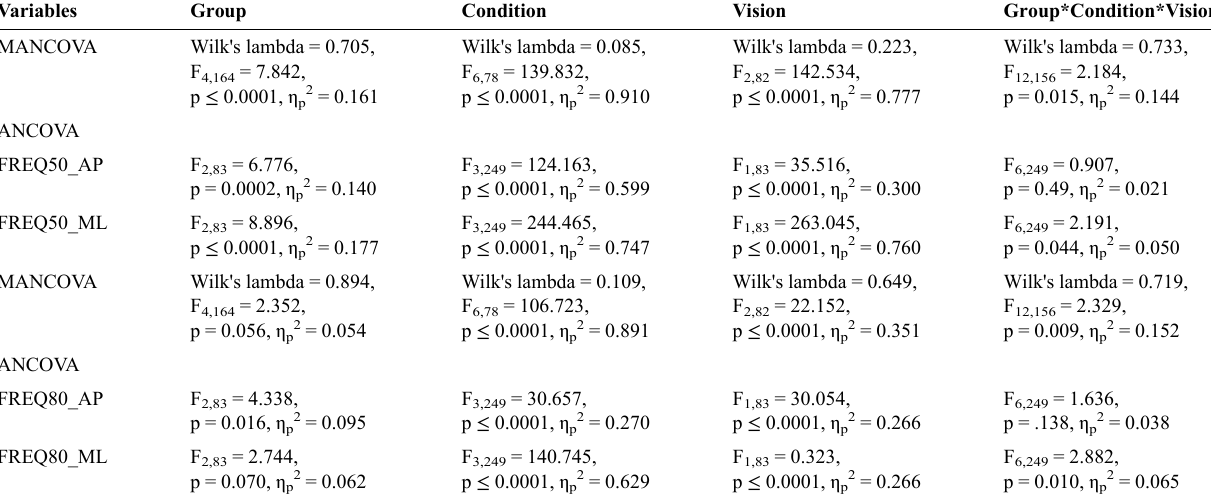
Table 3 - F, p, and η p2 values for the main effect and triple interaction between factors (group, condition, vision, and group*condition*vision) of MAN- COVAs and ANCOVAs for variables in the frequency domain: frequency 50% (FREQ50) and frequency 80% (FREQ80) of the total spectral density (PSD) in the anteroposterior (AP) and mediolateral (ML) directions.